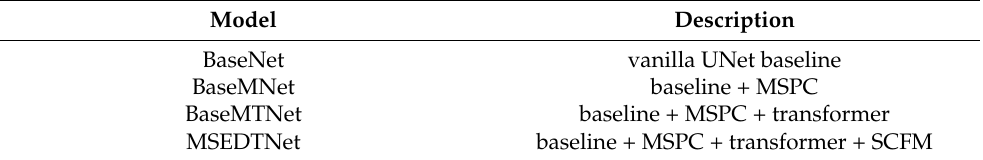
Table 1. Ablation